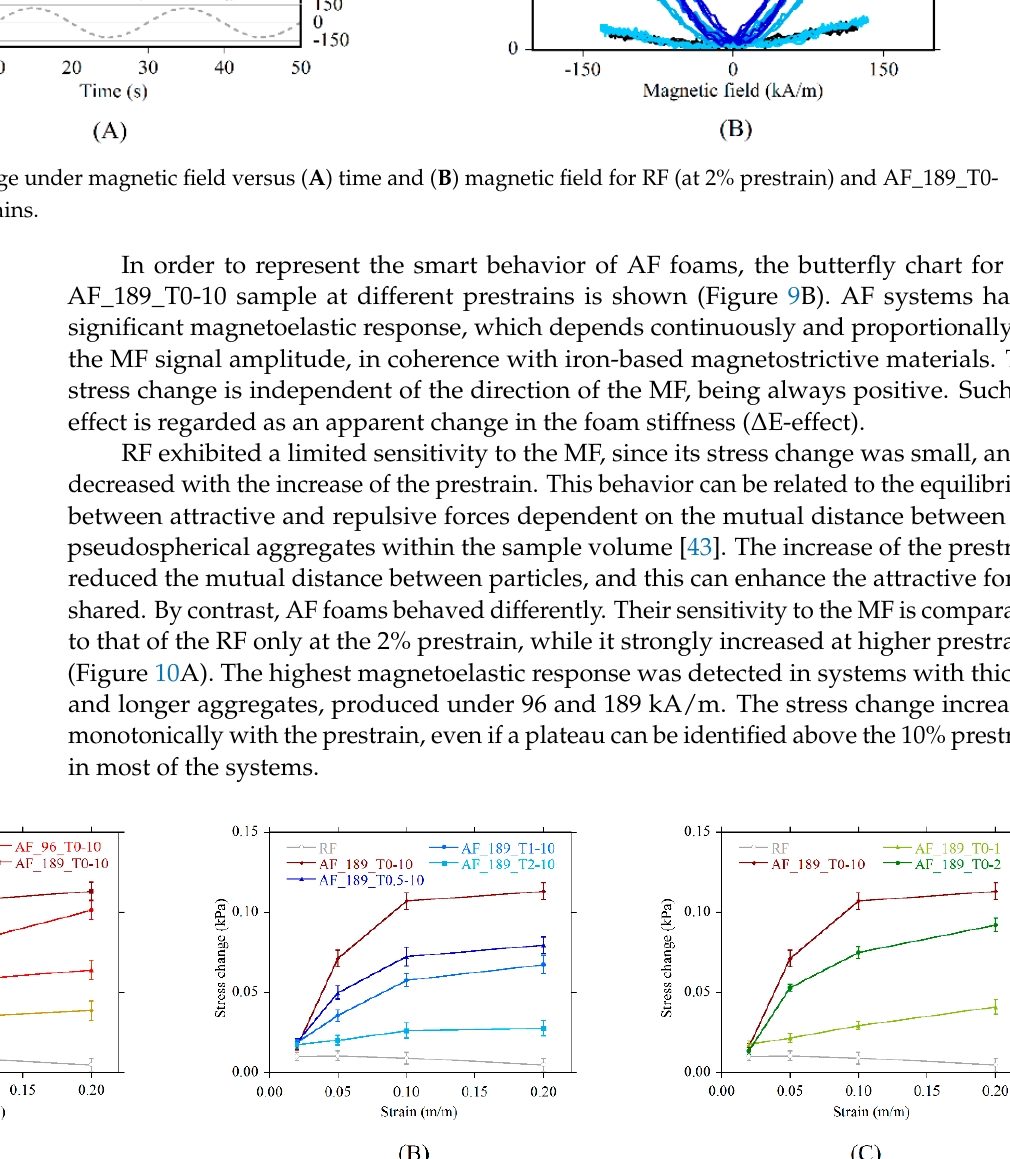
Figure 9. Stress change under magnetic field versus ( A ) time and ( B ) magnetic field for RF (at 2% prestrain) and AF_189_T0-10 at different prestrains.